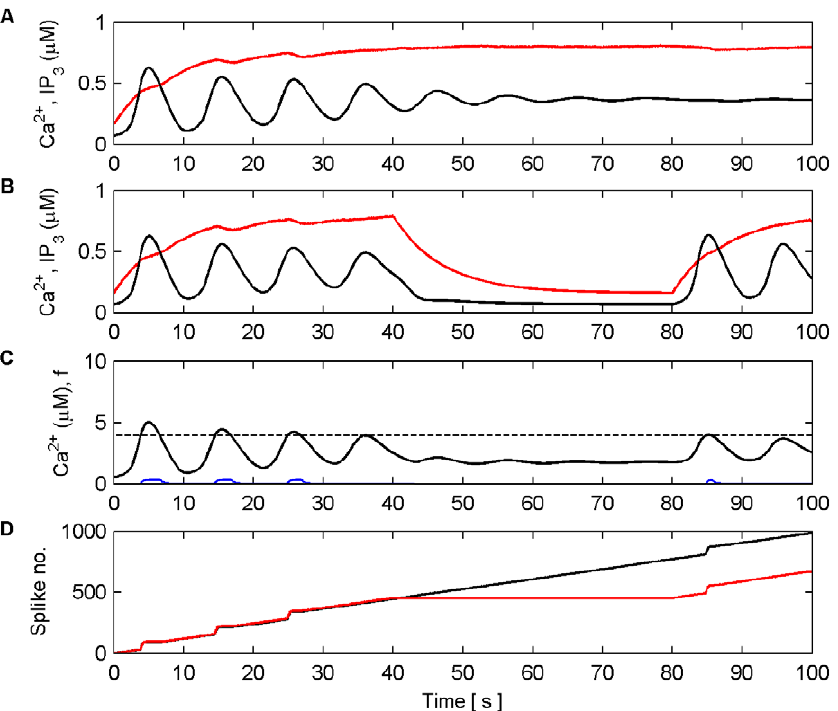
Figure 14. Loss of Ca 2 + oscillation in the synaptic microdomain. (A) Ca 2 + oscillation (black) and IP 3 levels (red) within a synaptic microdomain of N1. (B) Ca 2 + oscillation and IP 3 levels within a synaptic microdomain of N2. (C) Total Ca 2 + level within the astrocyte as a result of all synaptic microdomain oscillations and the f function (blue).(D) Neural output of N1 (black) and N2 (red) as spike count as a function of time. Since the threshold is close to the peak of the total Ca 2 + oscillation f is only active for a short period. Therefore the reduction of IP 3 due to synaptic neurotransmitter release depression cannot prevent IP 3 levels reaching a point at which the sustained Ca 2 + oscillations cease at synapses associated with N1. This is not the case at synapses associated with N2 as there is no synaptic input stimulation between 40 s and 80 s and IP 3 levels degrade naturally. Furthermore, the coordinated activity also changes: between 40 s and 80 s there is no bursting activity in either neuron since the total Ca 2 + level is insufficient to cross the